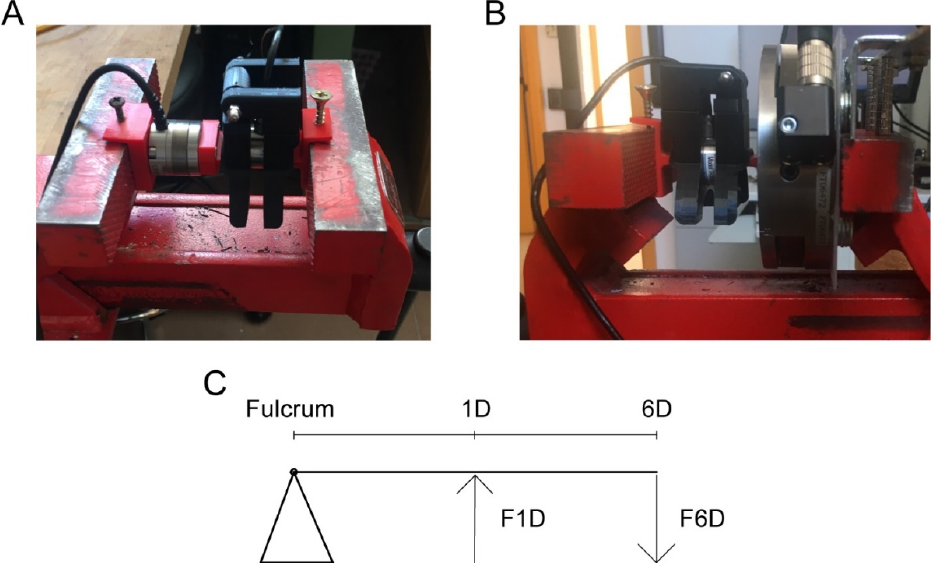
Figure 5. Calibration procedure. A manual press machine applies several loads on the device through a second calibrated load cell. ( A ) The calibration procedure used a small 6D force transducer (max force 500 N) as the second device; ( B ) the setup with a large 6D force transducer (max force 495 N). ( C ) Schematic representation of the second-order lever, which characterizes the calibration process. In particular, the press machine exerts a force on the 6 DOF ( F6D ) sensor, which can be placed at a variable distance ( ∆ d = d 6D − d 1D ) from the main axes of the 1 DOF. d 6D and d 1D are, respectively, the distances from the fulcrum of the lever of the 6 DOF and 1 DOF sensors. F1D is the resulting force recorded on the 1 DOF sensor.